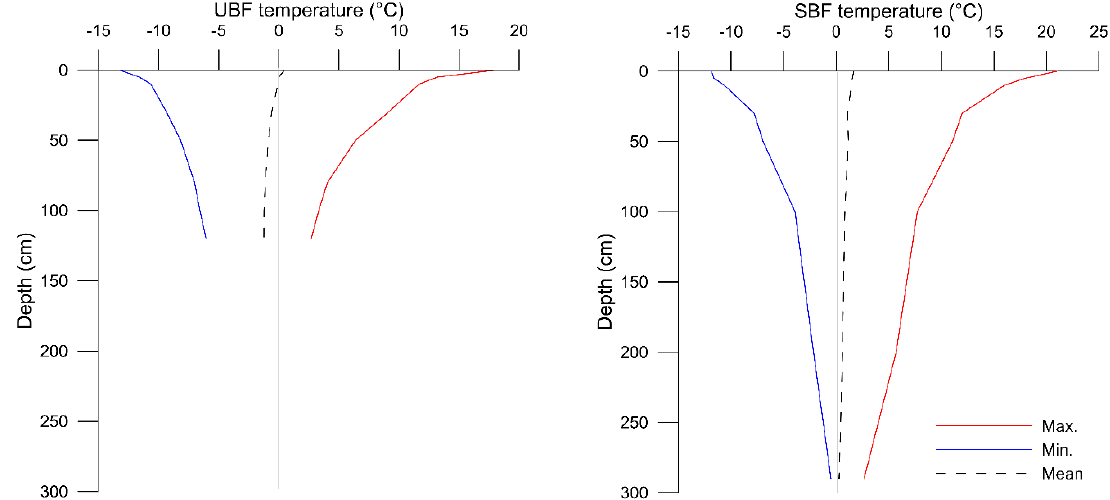
Figure 9. Annual maximum, minimum, and mean temperatures at the unburned (UBF) and severely